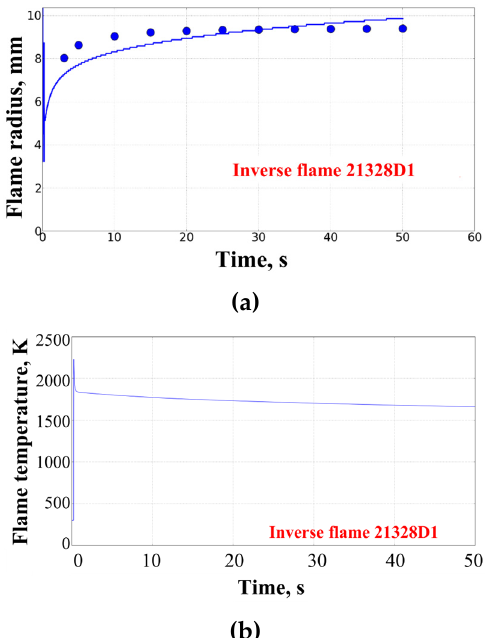
Figure 5. Examples of time histories of the size ( a ) and temperature ( b ) of a quasi-stationary inverse flame. Symbols correspond to the experiment, and the curves correspond to the calculation.